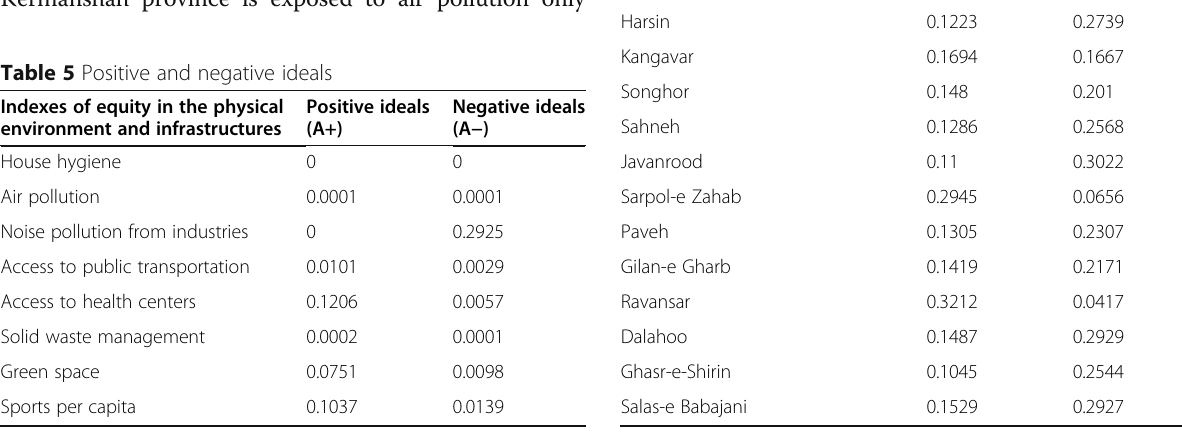
Positive ideals